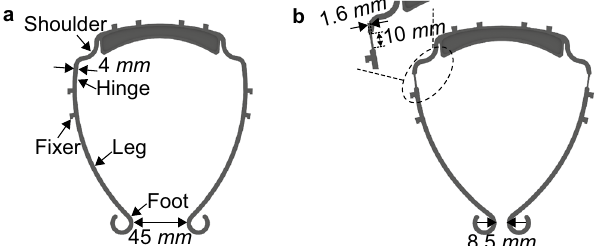
Figure 1. Visor frames. ( a ) Normal visor frame. ( b ) Redesigned visor